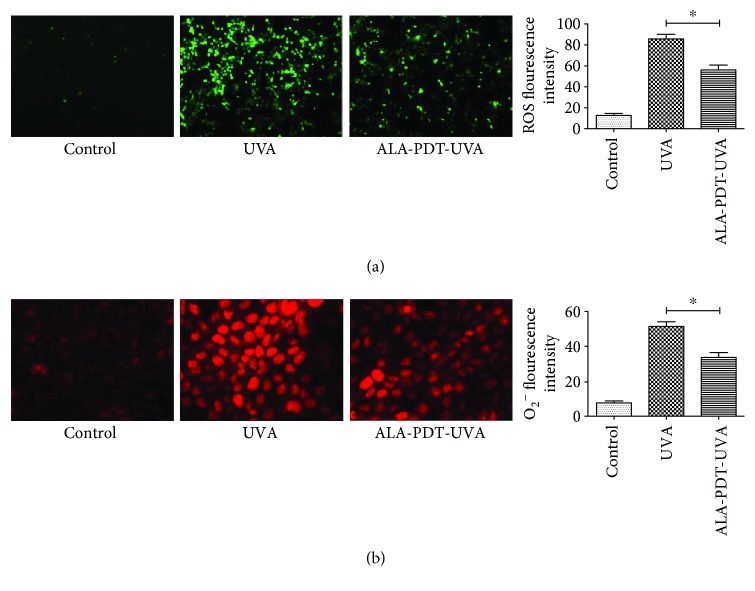
UVA-induced oxidative damage was reduced with ALA-PDT pretreatment. (a, b) Cells were treated with a sublethal dose of ALA-PDT, then these cells were irradiated with 10 J/cm2 of UVA light. Cells were incubated with 10 μmmol/L DCFH-DA or 5 μmmol/L Dihydroethidium for 20 min, after which ROS and O2− production was visualized by fluorescence microscopy. Intracellular ROS and O2− species exhibited green and red fluorescence under a fluorescence microscope; the fluorescence intensity was determined by a fluorescence microplate reader. Data were expressed as mean ± SD, n = 3 for each group, ∗p < 0.05.